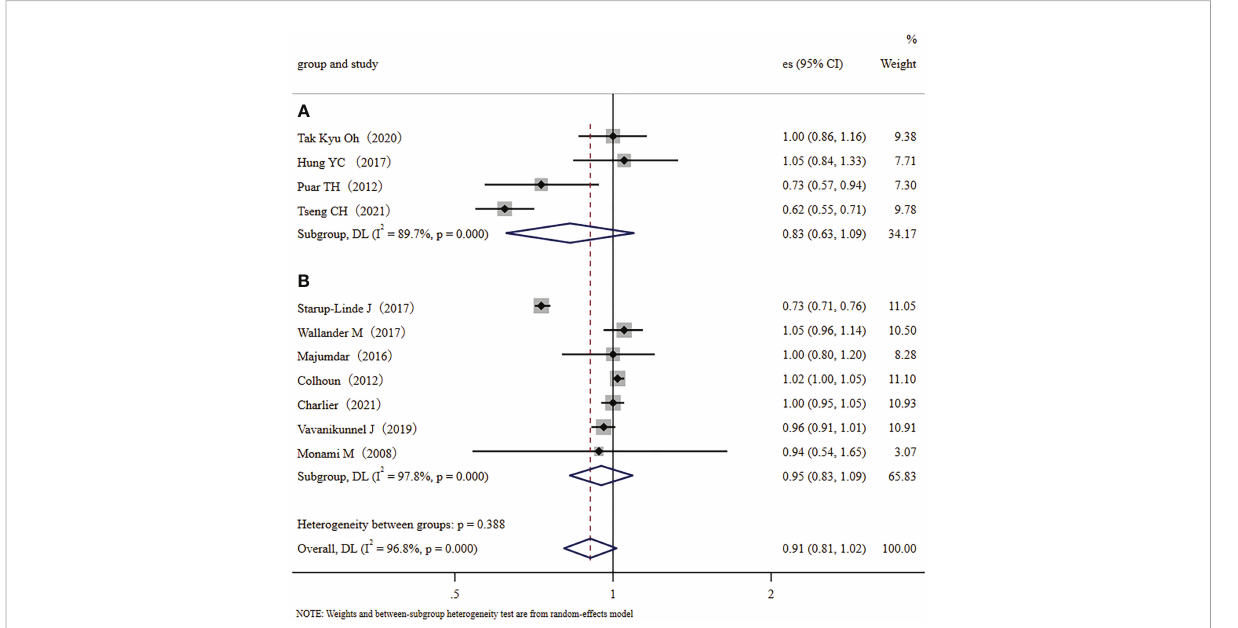
FIGURE 4 The ethnic subgroup analysis: (A) : Forest plot of the four studies that were performed in Asia (major population: Far-Eastern origins); (B) : Forest plot of the seven studies that were performed in Europe/the United States (major population: European origins); Study: author and year of publication; es, effect size; 95% CI, 95% con fi dence interval; Weight,